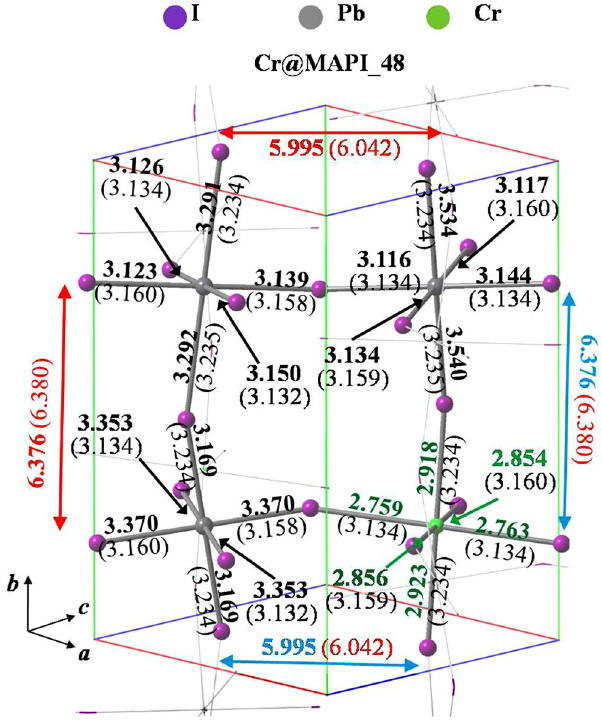
Figure 2. Optimized structures of Cr@MAPI_48 perovskite, along with bond lengths of I-Pb (black), I-Cr (green), Pb-Pb (red) and Pb-Cr (blue). Values in parenthesis stand for those bond lengths for the optimized structures of the native MAPI. For clarity, Pb-Pb and Pb-Cr bond distances are displayed outside of the unit cell. Methylammonioum cations were omitted for